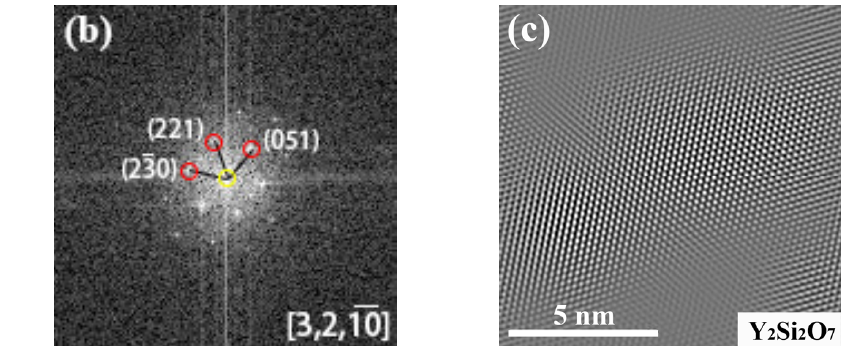
micrograph by ( a ); ( c ) IFFT filtered image derived from three adjacent diffraction points in ( b ).